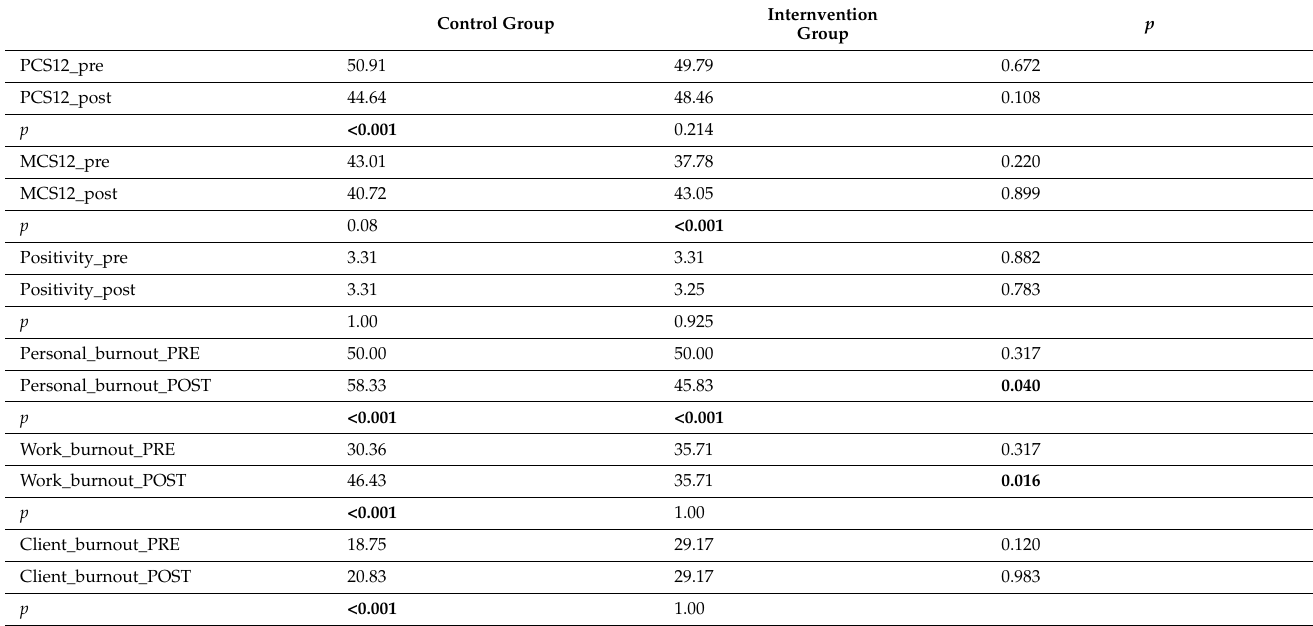
Table 4. Results related to MCS, PCS, positivity score and